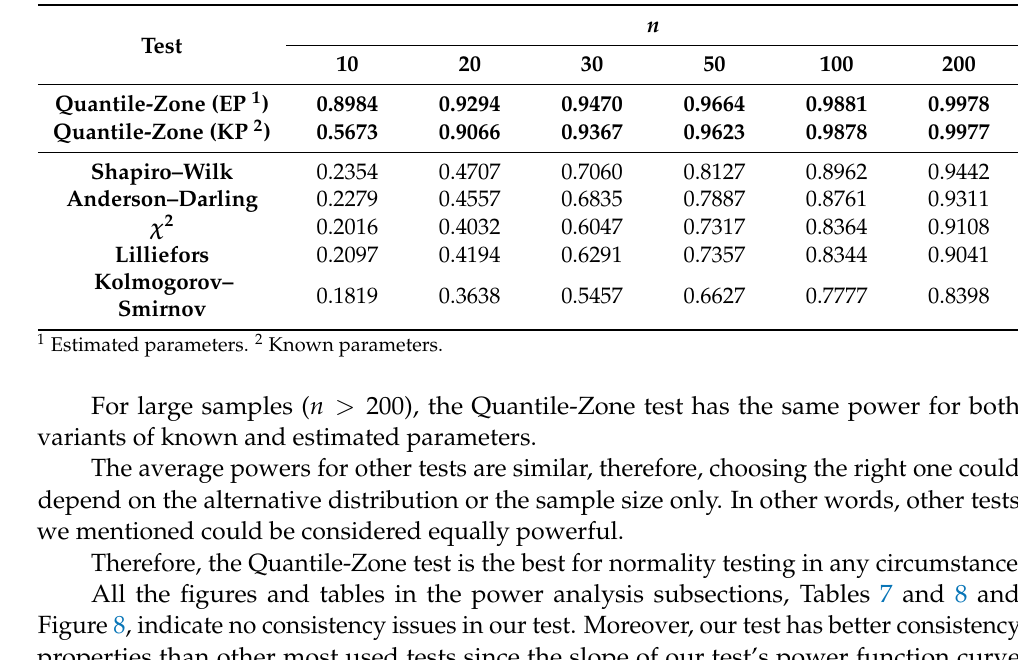
Table 8. Average empirical power values of statistic V n and some other normality test statistics for various sample sizes with the level of significance α = 0.05—Asymmetric alternative distributions.